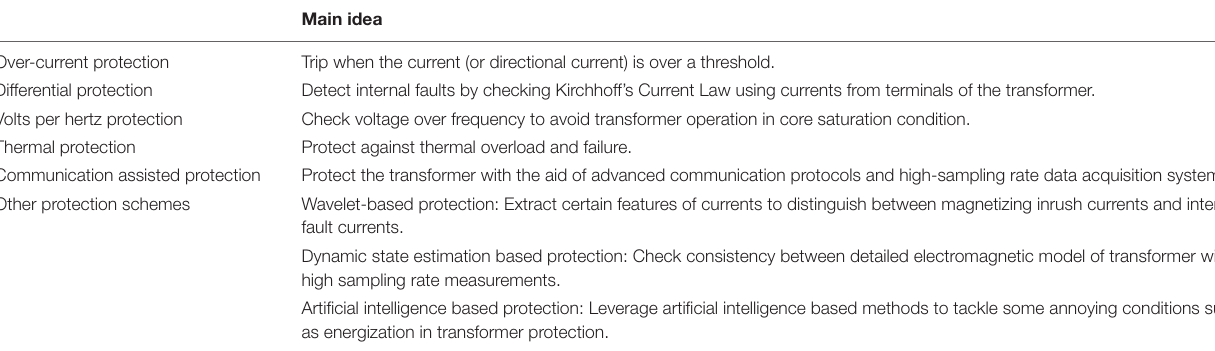
TABLE 3 | Summary of protection of low frequency power transformers.